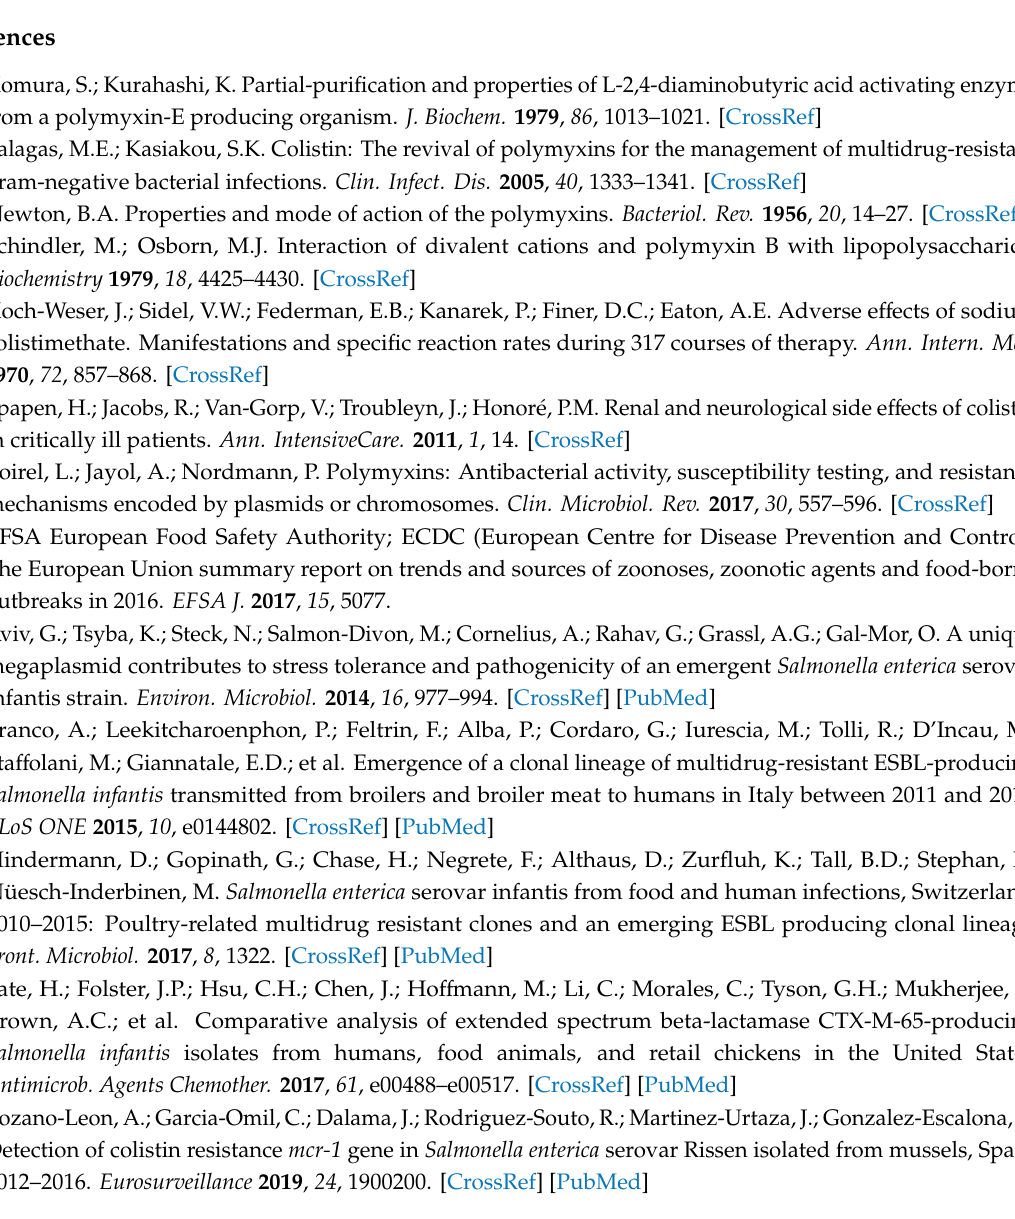
Table S1. Antibiogram pattern of pathogenic microbes against colisitn isolated from